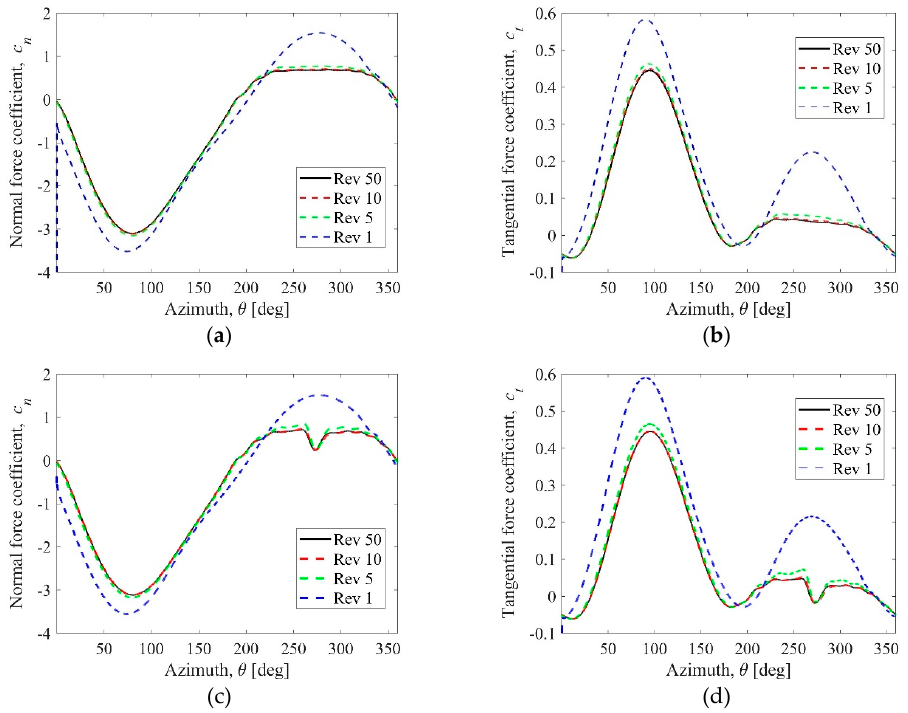
Figure 11. Aerodynamic forces for example rotor rotations. ( a ) Normal force coefficient for clean rotor; ( b ) Tangential force coefficient for clean rotor; ( c ) Normal force coefficient for the shafted rotor; ( d ) Tangential force coefficient for the shafted rotor.